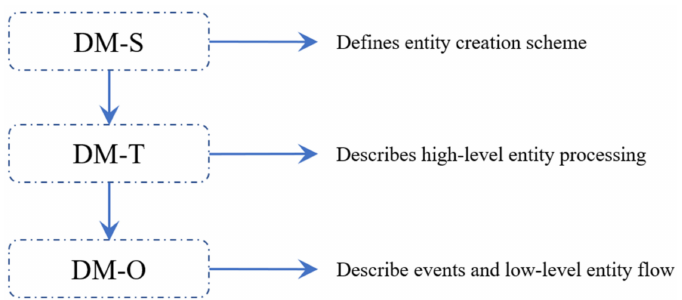
Figure 12. Design Model in the Layered Template Form.